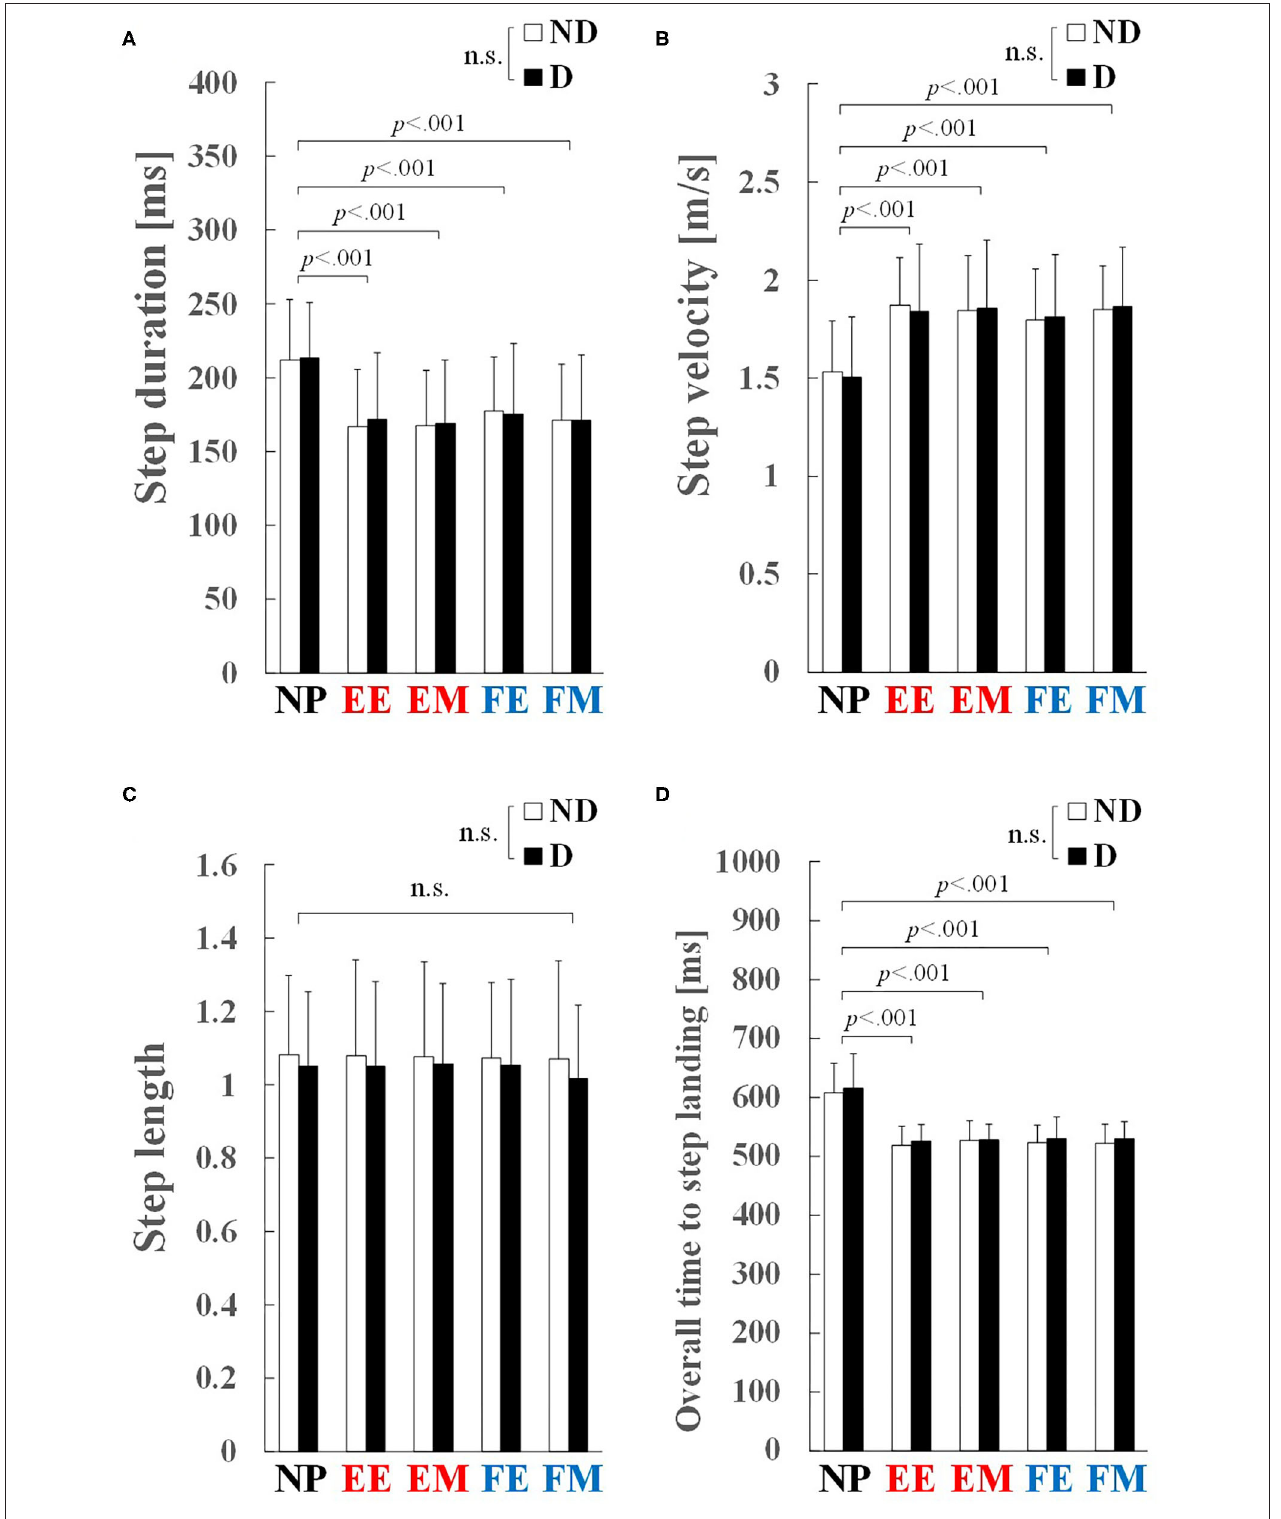
FIGURE 5 | Step-execution characteristics: (A) step duration, (B) step velocity, (C) step length, and (D) overall time to step landing. Values and error bars are mean and SD. EE and EM, early and middle phases of the knee extension phase; FE and FM, early and middle phases of the knee flexion phase; ND, non-dominant; D, dominant. Step length was normalized to the stance width, and therefore is a unitless value.